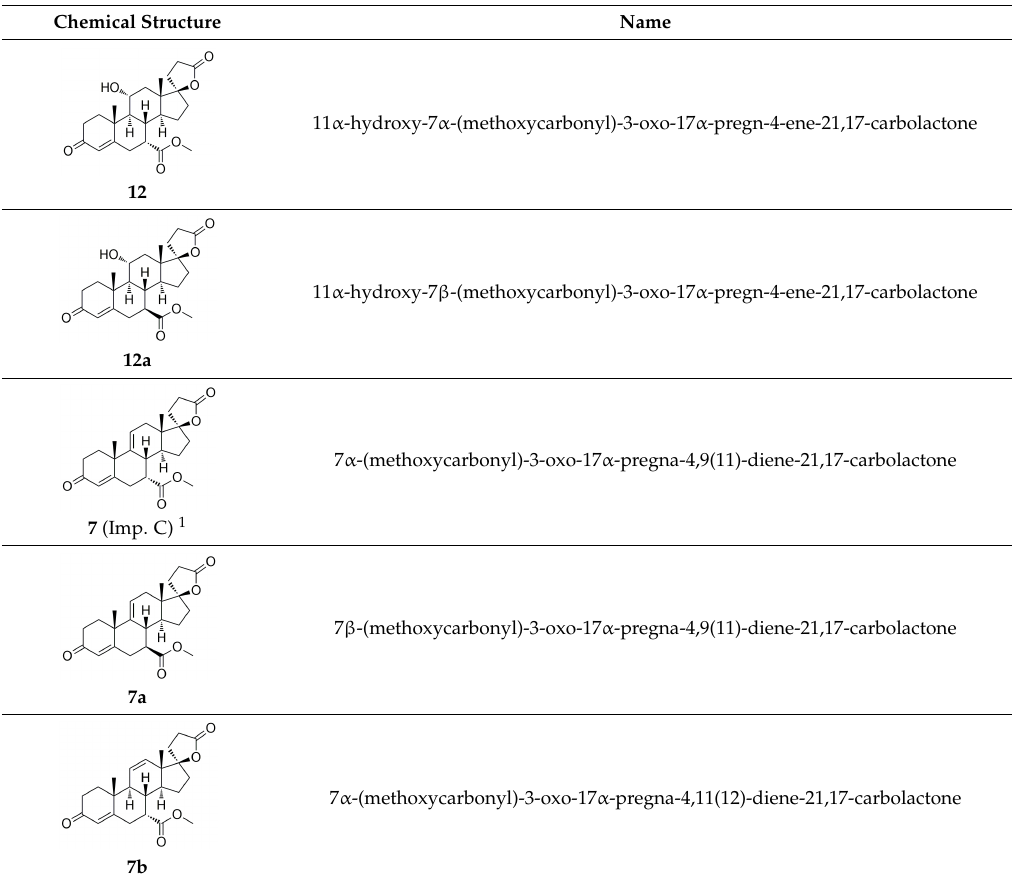
Table 1. Structures of the process-related impurities of eplerenone ( 2 ).